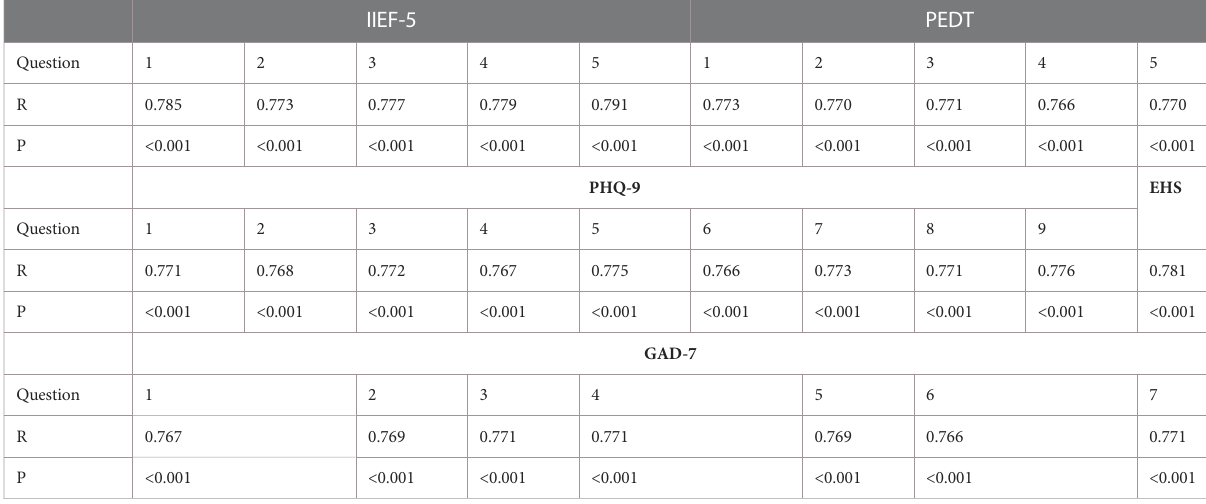
TABLE 1 Test − retest correlation coef fi cients (R) and P values of IIEF-5, PEDT, PHQ-9, EHS and GAD-7. IIEF-5